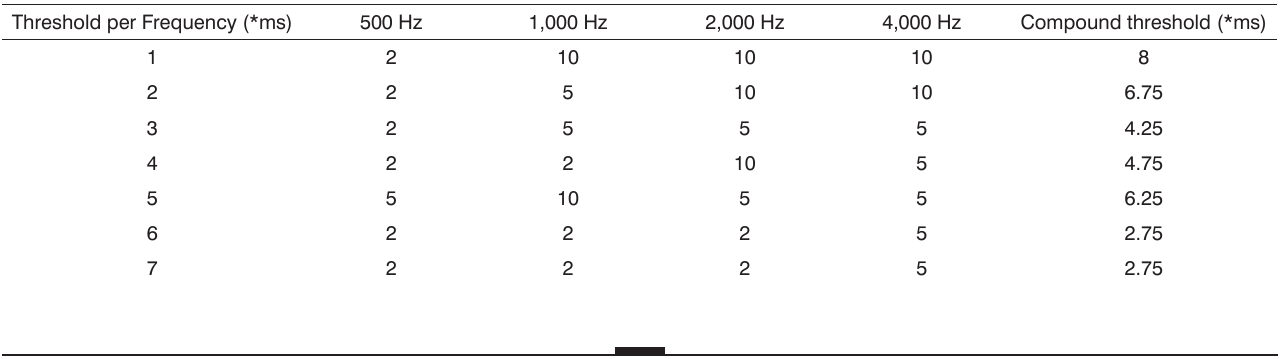
Frame 1. Analysis of random gap detection thresholds per frequency and compound thresholds for each participant, and the group mean - using the RDTG